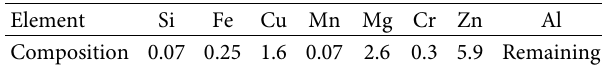
Table 1: Chemical composition of the AA7075 alloy (Spectrum